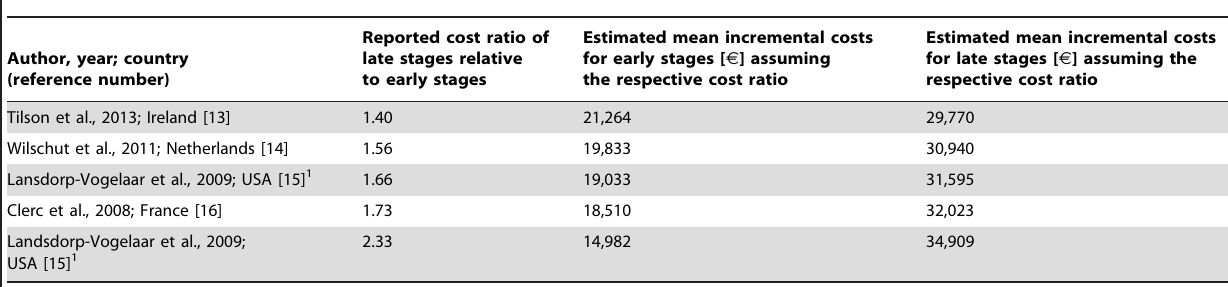
Table 2. Estimates on CRC treatment costs (annualized) regarding the initial phase of care stratified by early stages (UICC I and II) and late stages (UICC III and IV) using information on cost ratios of late stages relative to early stages as reported from the literature (the formula to derive these estimates is explained in the Appendix